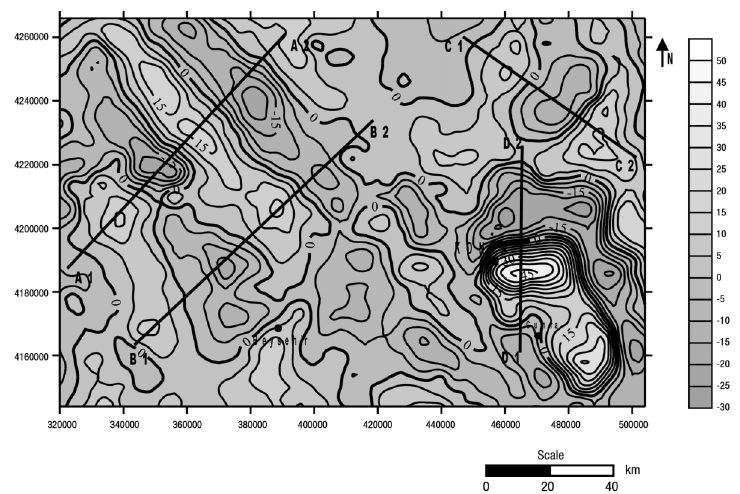
Fig. 8. Residual anomaly map obtained by low-pass filtering ( A to construct the residual field; the contour interval is 5